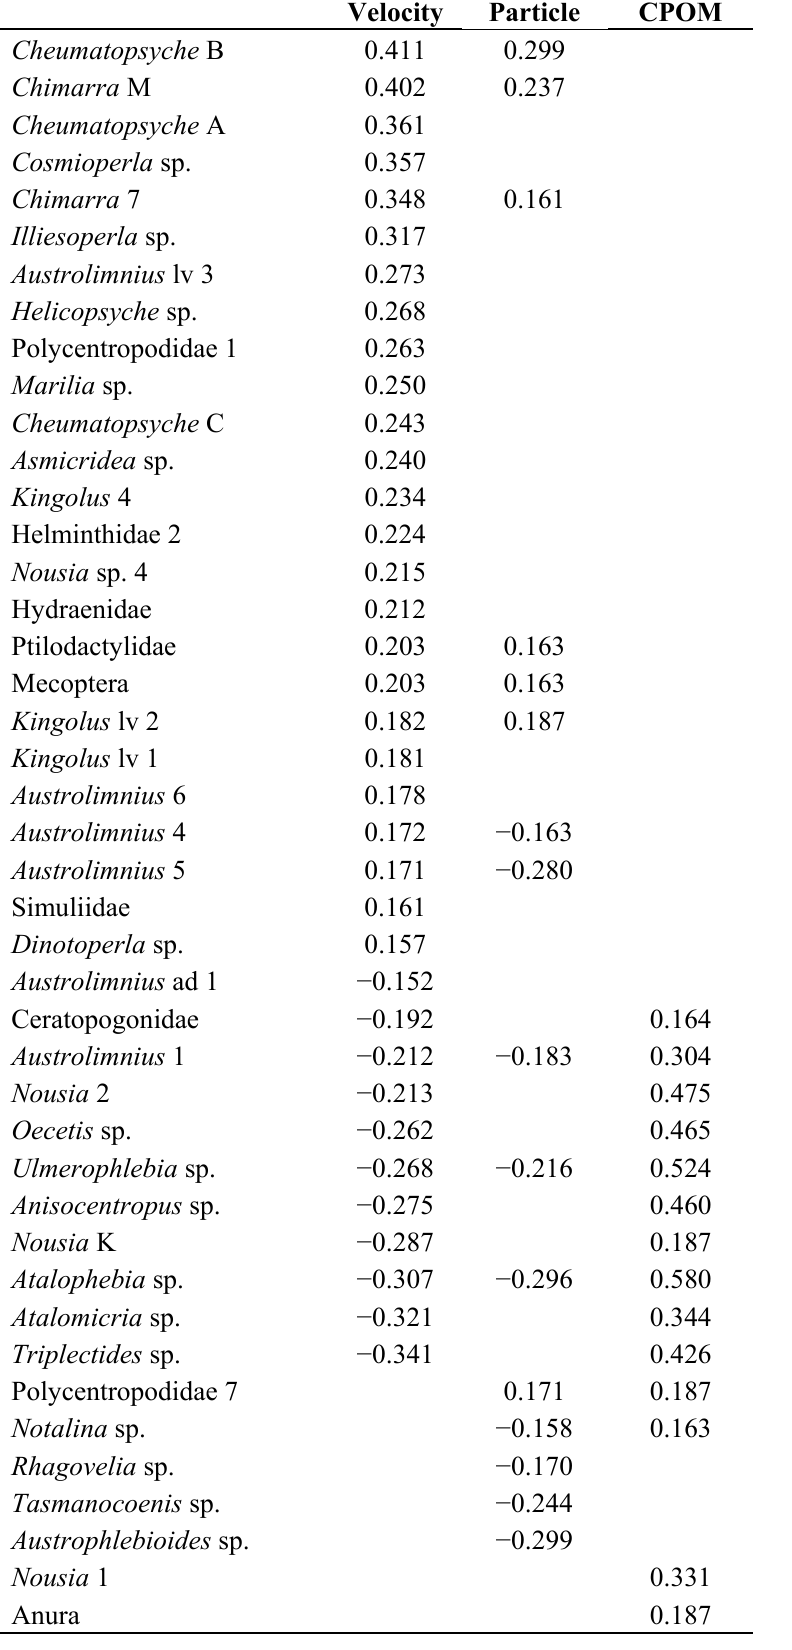
Table A2. Correlations between abundances of invertebrate taxa and current velocity, maximum particle size of the substratum and CPOM cover of the substratum. Values of r given only where p < 0.05. Note that “significant” values range between equivalent r 2 values of only